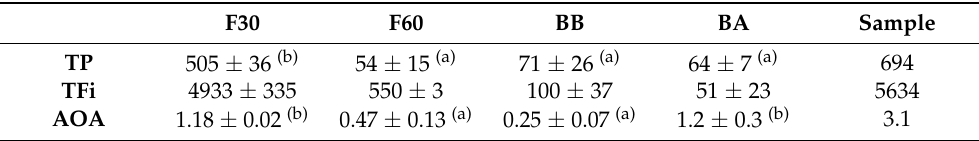
Table 1. Total phenolic content (TP, mg GAE/100 g (db), antioxidant activity (AOA, mmol Trolox/100 g (db)) and sum of the identified flavonoids (Fi, mg/100 g (db)) in the 4 phenolic extracts obtained (codes according to Section 2.2). The sample column corresponds to the sum of the 4 extracts.